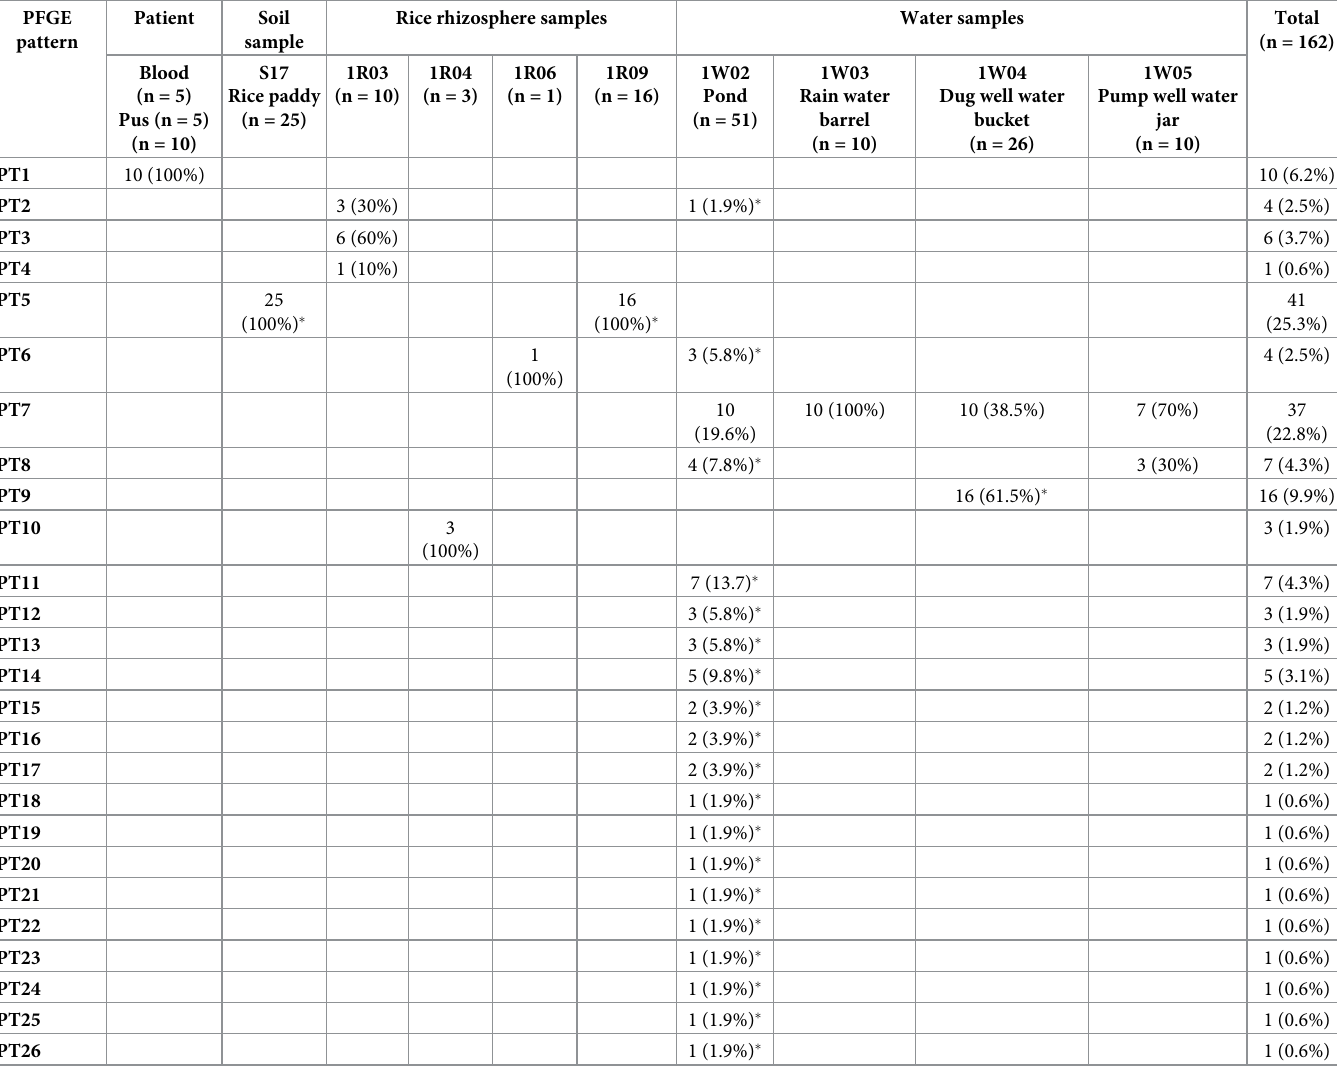
� Indicates B . pseudomallei isolates collected at the second